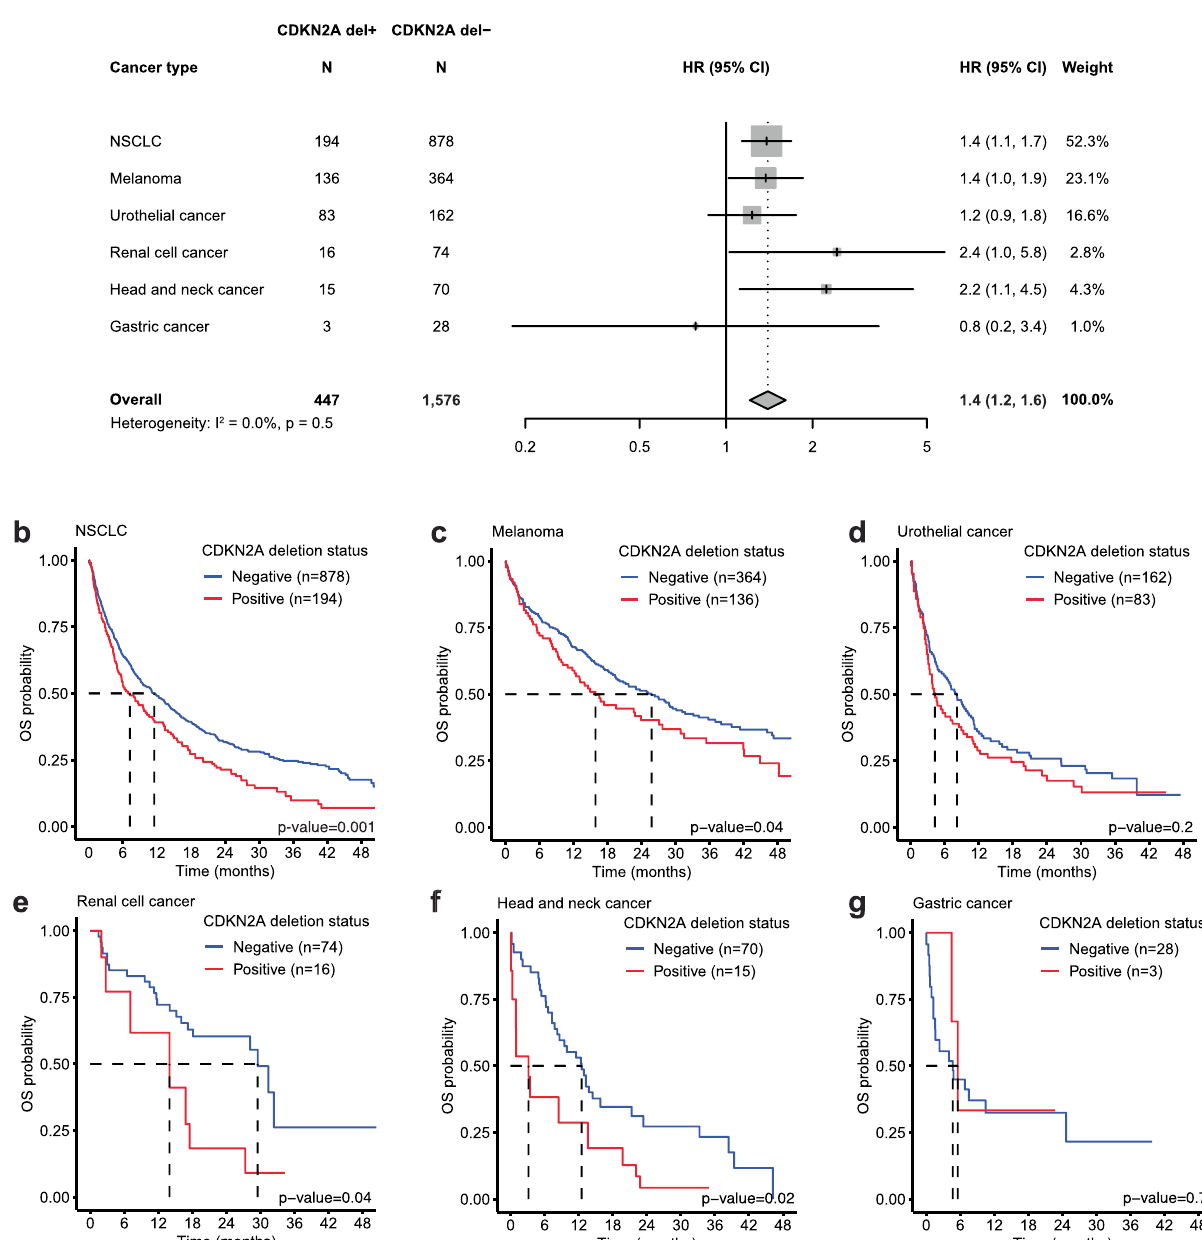
Fig. 5 CDKN2A deletion is associated with worse immune checkpoint inhibitor response across multiple cancer types. a Forest plot of hazard ratios and 95% CIs of overall survival according to CDKN2A deletion status in immune checkpoint inhibitor-treated patients across cancer types. Hazard ratios and 95% CIs from each study were used to calculate a pooled HR. The pooled estimate was calculated using a random-effects meta-analysis. Statistical heterogeneity was assessed using the Cochran ’ s Q test and I 2 statistic. b – g Kaplan – Meier plot of overall survival according to CDKN2A deletion status in immune checkpoint inhibitor-treated patients with b NSCLC, c melanoma, d urothelial cancer, e renal cell cancer, f head and neck cancer, and g gastric